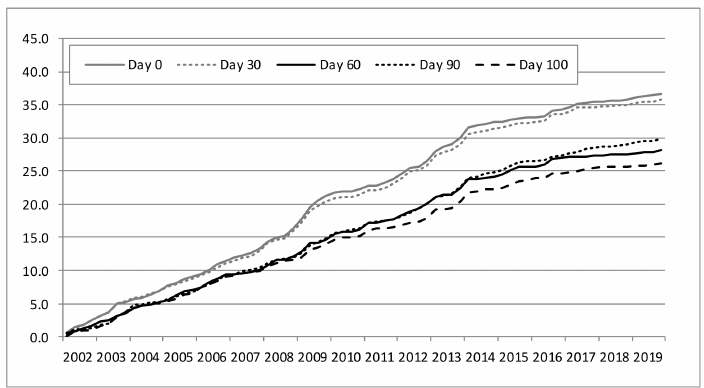
Figure 3. Cumulative absolute out-of-sample forecast error of the median of Models 1 to 6 with last- error correction progressively updated with more data over the current quarter (percentage points,